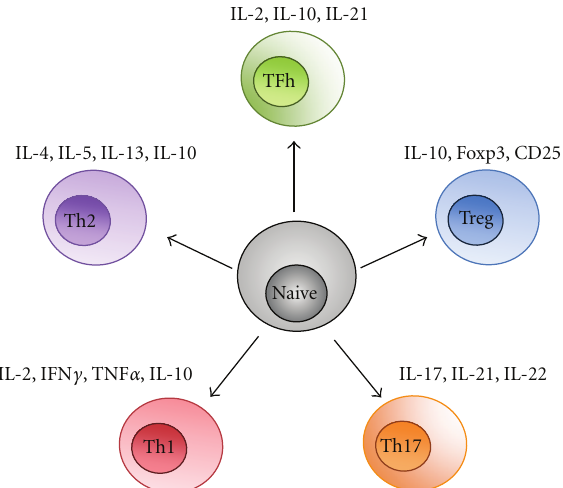
Figure 1: CD4 + T Cells di ff erentiated into subsets. CD4 + T cells can di ff erentiate into di ff erent subtypes based on the factors within the inflammatory milieu with which T cells come into contact. TH1 + cells secrete IFN- γ and tumor necrosis factor (TNF) and mediate the pathology in experimental autoimmune encephalomyelitis (EAE). Many of the results previously attributed to TH1 cells are actually mediated by Th17 + cells. Th17 + cells secrete IL17, IL21, and IL22. These cells have been identified in MS lesions, where they may serve as important e ff ectors. As a result of TGF- β stimulation, CD4 + T cells develop into T-regulatory cells. These cells downregulate the immune response and express FOXP3, CD25, and IL10. The mechanism of suppression is by the secretion of factors such as IL10. TH-helper cells provide help to other T cells, such as CD8 + T cells or B cells. Th-helper cells secrete IL2, IL10, and IL21. Th2 + cells downregulate the immune response and are associated with recovery from acute attacks in EAE and, possibly, MS. The cytokines that mediate the downregulation of the immune response are IL4 and IL10, in addition to IL13 and